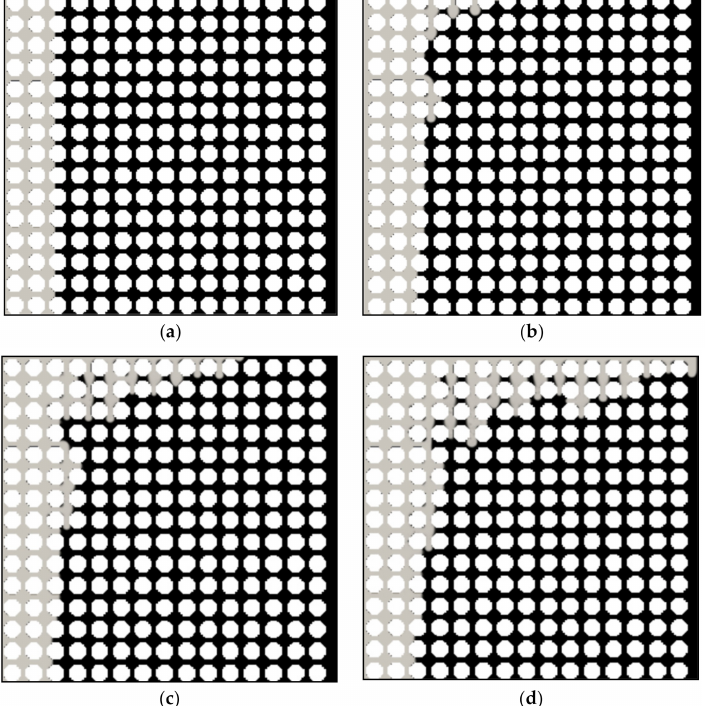
Figure 5. VAPEX interface in butane advance in porous media. The black and grey colors show oil and solvent phases, respectively, and the white shapes are grains. ( a – d ) are chamber at the initial condition and after 2000 s, 4000 s, and 6000